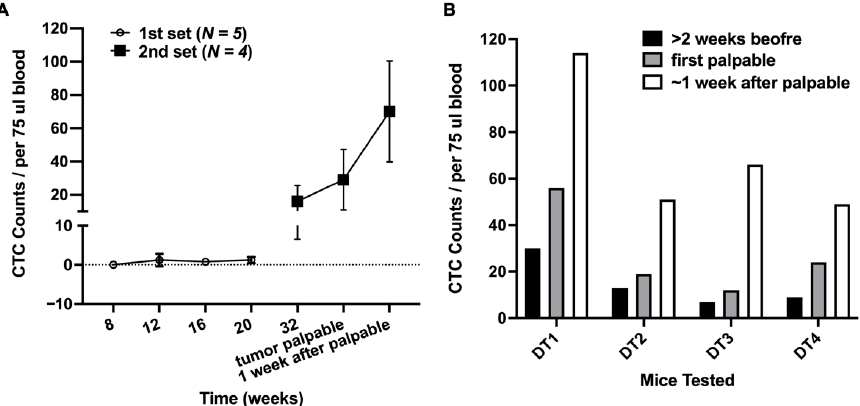
Figure 4. CTC counts in NTTg mice over time. ( A ) circles: Average CTC enumeration at 8, 12, 16, and 20 weeks of age in the first set of five mice; squares: Average CTC enumeration at 32 weeks of age, the week when the tumor was first detected by palpation, and approximately one week after the tumor was detected in the second set of four mice. ( B ) CTC enumeration of each of the second set of four mice (DT1–DT4) prior to, at the time of, and after the tumor became palpable. In addition to enumerating the CTC count of the NTTg mice, once the tumor became palpable, we measured the tumor size and vascularity every week with ultrasonography with Doppler capabilities. The use of the ultrasonography system enabled us to monitor tumor angiogenesis and density, without needing to sacrifice the mice. To measure the volume of the tumor tissue, we reconstructed a stereo model of the tumor by drawing the contour manually to exclude the mucinous pool (hypoechoic area), and then calculated the volume as shown in Figures 5A, 5B. We determined the vascularity of the tumors with the embedded Doppler function of the ultrasonography equipment. The function was verified by scanning a normal lymph node (Figure 5C). In this case, we were able to recognize efferent vessels (200 µ m in diameter) [24].